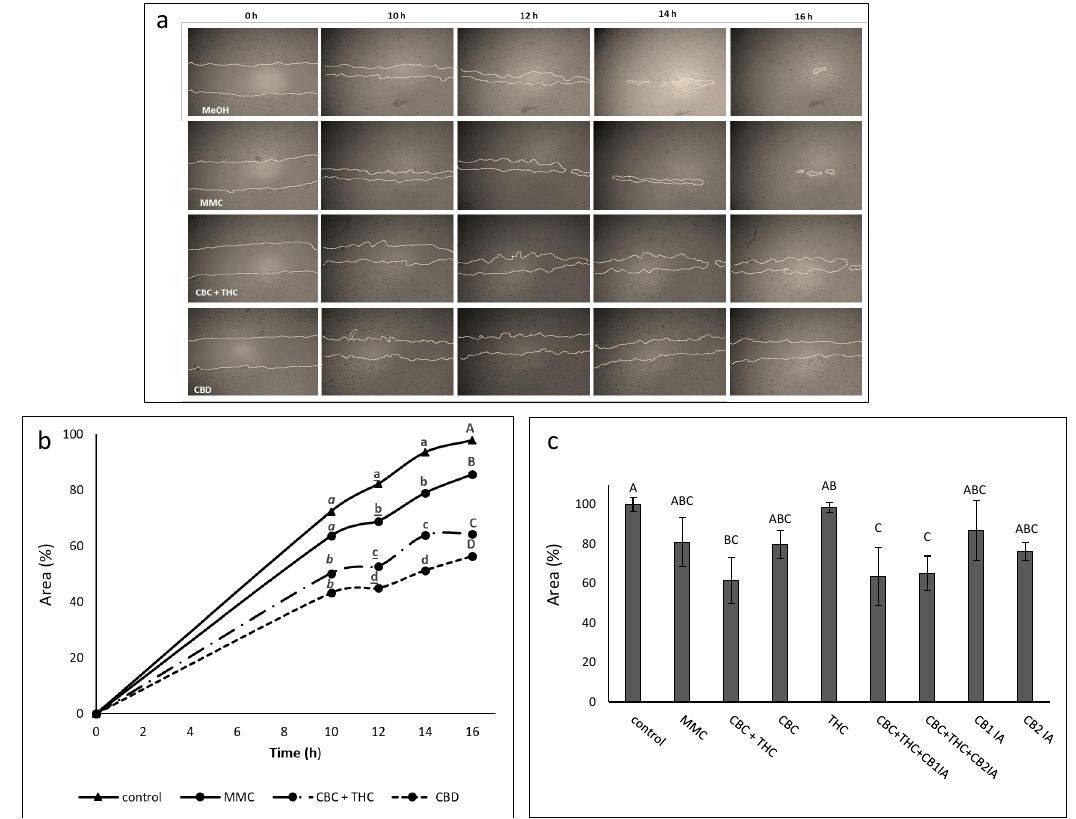
Figure 5. ( a ) Examples of pictures taken for estimation of the treatment effect of CBC + THC (8.6 + 1.4 µ g/mL respectively), CBD (10 µ g/mL) or Mitomycin-C (MMC, 4 µ g/mL) on recovered area of confluent monolayers of T24 cell line at 0, 10, 12, 14 and 16 h. Methanol (control) treatment served as solvent (vehicle) control. ( b ) The effect of treatment with CBC + THC (8.6 + 1.4 µ g/mL respectively) or CBD (10 µ g/mL) on the recovered area of confluent monolayers of the T24 cell line. ( c ) The effect of treatment with CBC+THC (8.6 + 1.4 µ g/mL respectively), CBC (10 µ g/mL), THC (10 µ g/mL) or CBC+THC (8.6 + 1.4 µ g/mL respectively) with CB1 or CB2 IA (10 µ M) on the recovered area of confluent monolayers of the T24 cell line at 14 h. Mitomycin-C (MMC, 4 µ g/mL) served as a positive control. Methanol (control) treatment served as solvent (vehicle) control. Values are means ± SE ( n = 12). Values with different letters of the same font are significantly different from all combinations of pairs according to Tukey–Kramer honest significant difference (HSD; p ≤